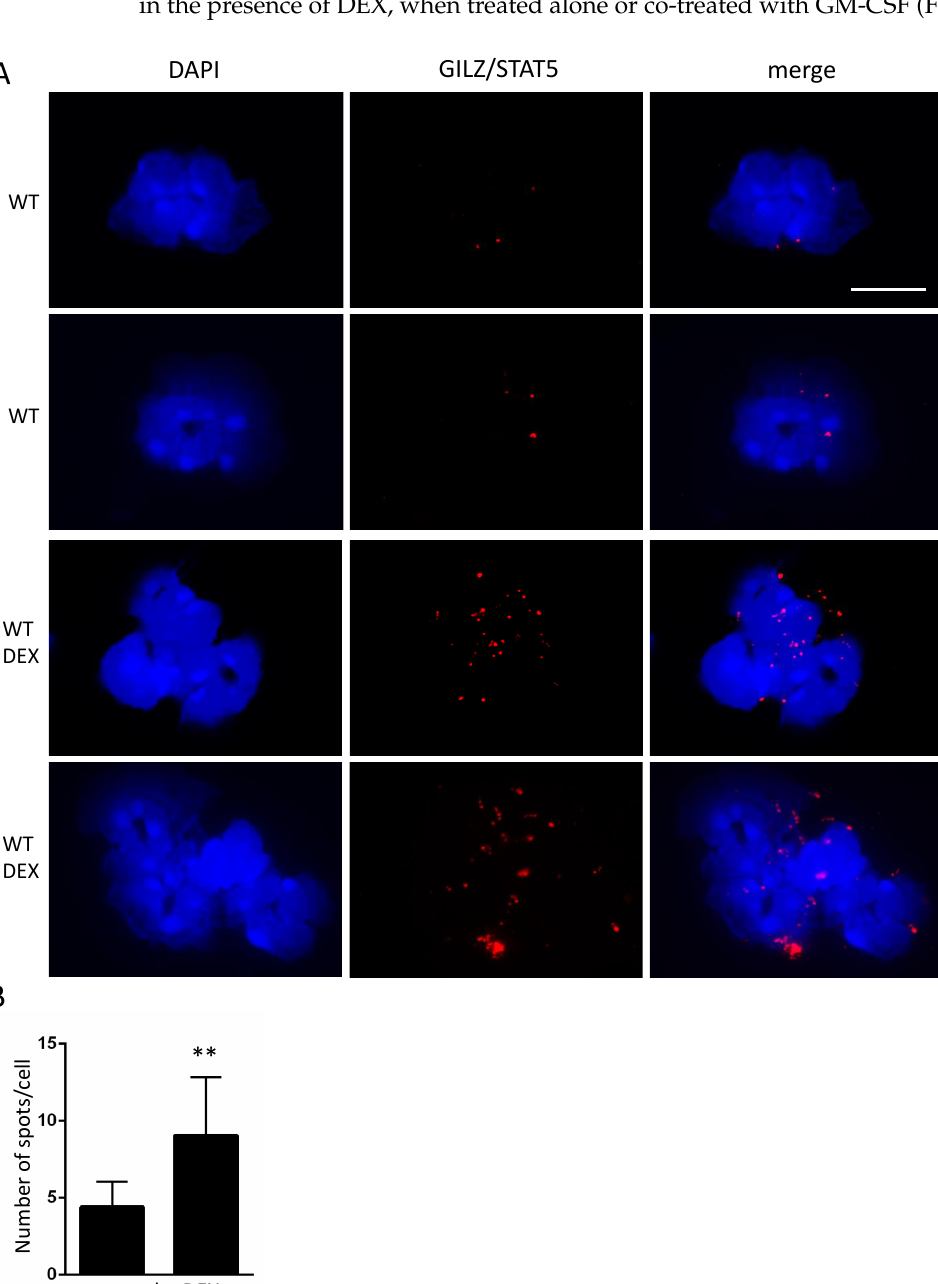
Figure 4. GILZ and STAT5 interact in DEX-treated neutrophils. ( A ) An in-situ proximity ligation assay in isolated peripheral Figure 4 . GILZ and STAT5 interact in DEX-treated neutrophils WT and KO neutrophils of in vivo DEX-treated mice. Red spots indicate a GILZ/STAT5 interaction: low number of spots were observed in the WT untreated mice (two upper rows of panels), whereas a higher number of spots were identified in DEX-treated cells (two lower rows of panels). ( B ) Statistical analysis of the spot number was performed using ICY free software. Two fields of representative stainings are shown (WT and WT+DEX). Values represent the means ± SD of more than 20 fields. Scale bar: 10 µ m. ** p <